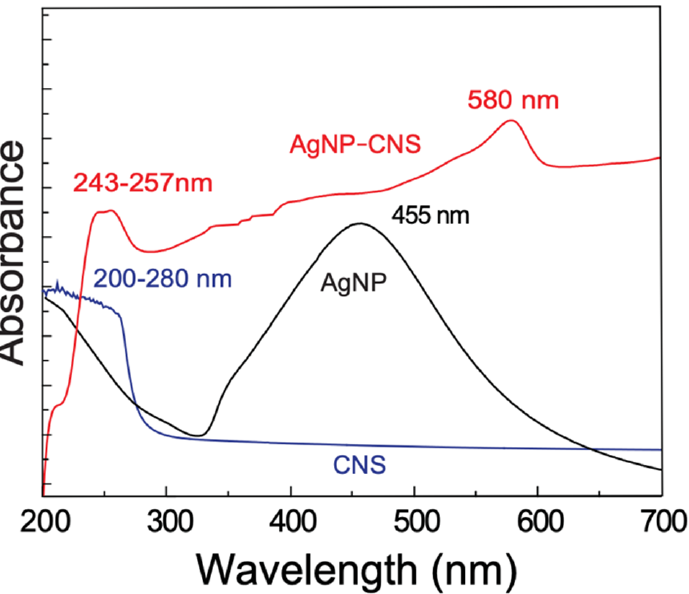
Figure 1. UV–Vis scans of the AgNPs (black), CNSs (blue), and the AgNP–CNS nanocomposite (red).